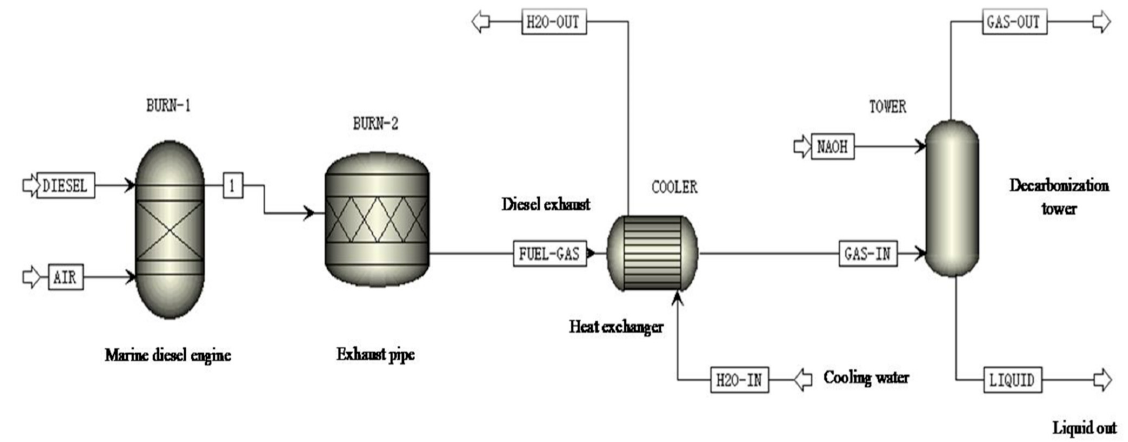
Figure 4. Simulation flow chart of decarburization process. Table 6. Parameters of flue gas and NaOH solution entering the spray tower.